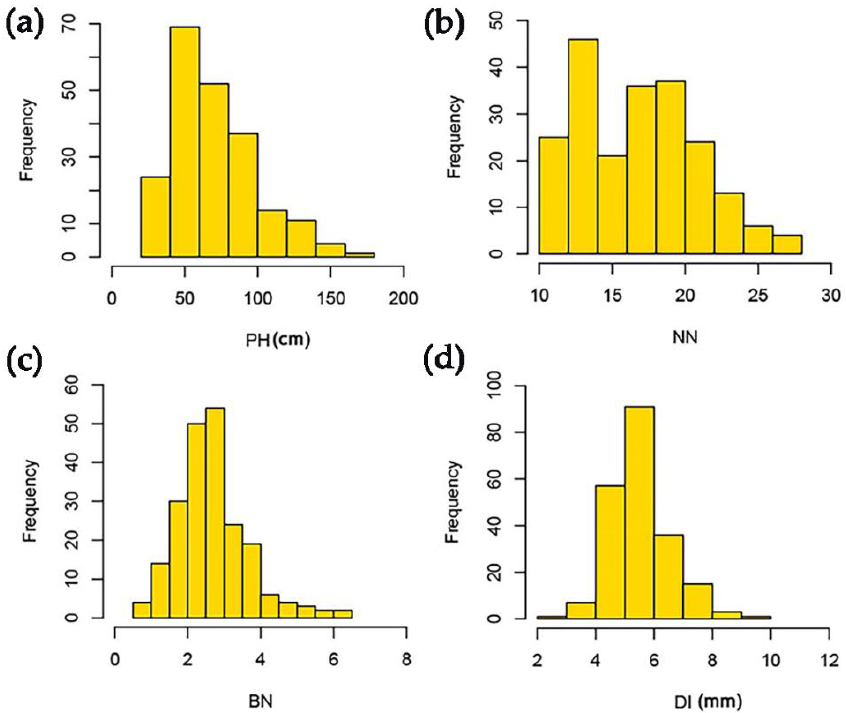
Figure 1. Boxplots of four plant architecture-related traits in soybean mini core collection in three environments. ( a – d ) Boxplots of PH, NN, BN, and DI.